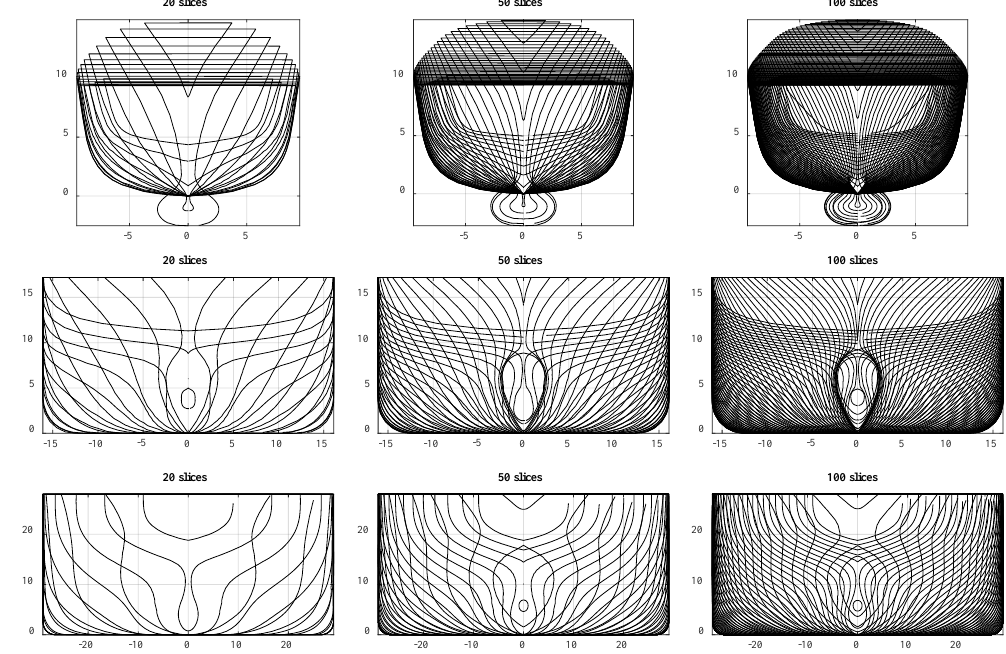
ff erent slice Figure 13. Body plan of different slice numbers. Figure 13. Body plan of different slice numbers. Figure 13. Body plan of di